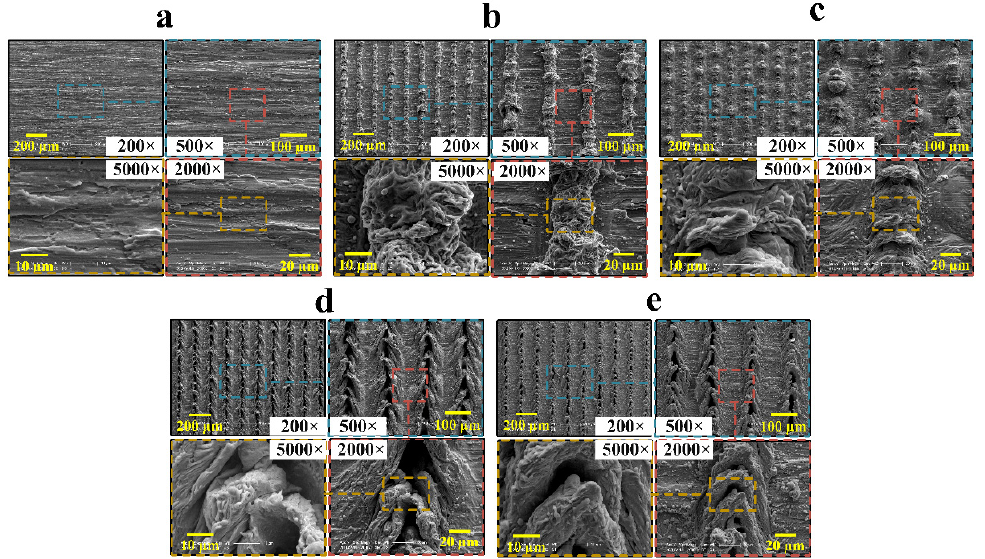
Figure 3. SEM micrographs of untreated BMG surface and laser-structured BMG surfaces at different scanning speeds: ( a ) untreated surface; ( b ) 20 mm/s; ( c ) 40 mm/s; ( d ) 60 mm/s; ( e ) 80 mm/s.